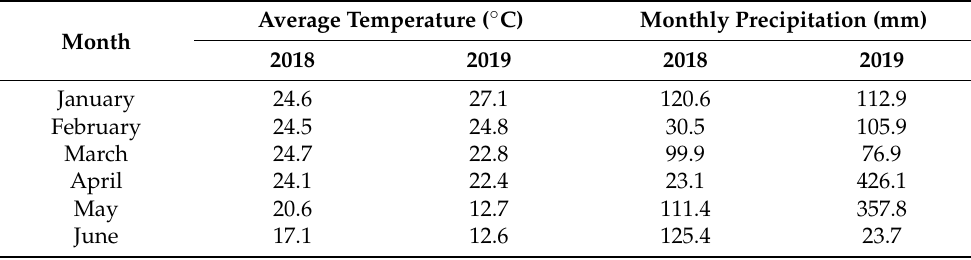
Table 1. Monthly weather data during the experiment in Orleans, SC, Brazil.